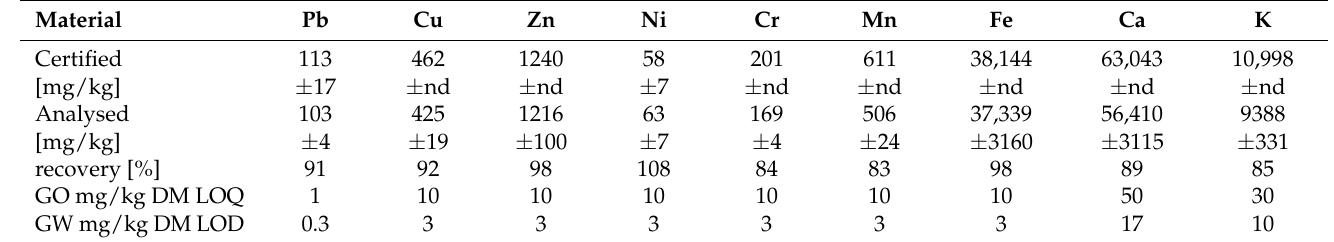
Table 3. Results of the analysis of certified material ‘Fine Dust (PM10-LIKE)’ No. ERM-CZ120 and detection limits for dust with mass from 0.1 g and volume 25